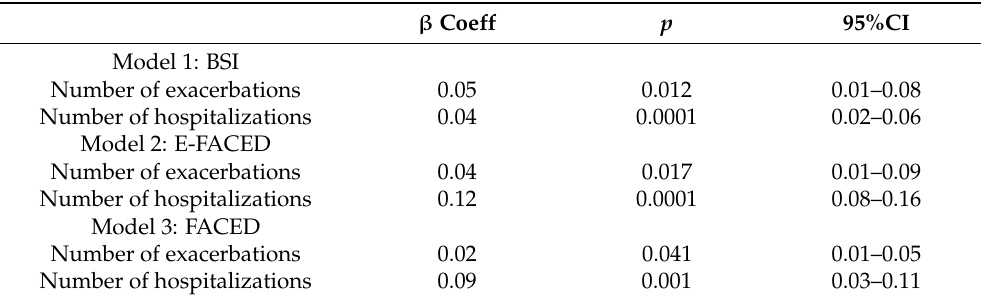
Table 3. Simple linear regression. Prognostic value of the neutrophil-to-lymphocyte ratio for exacer- bations and hospitalizations according to three different models adjusted for gender and treatments, based on the various severity scores for bronchiectasis.